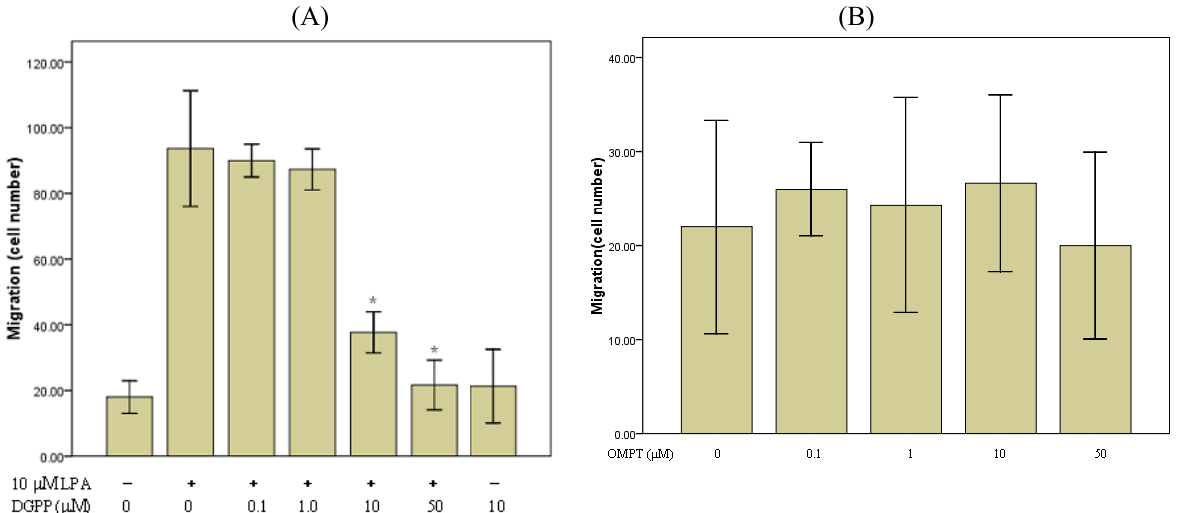
Figure 3. Involvement of specific LPA receptor subtypes in LPA-induced